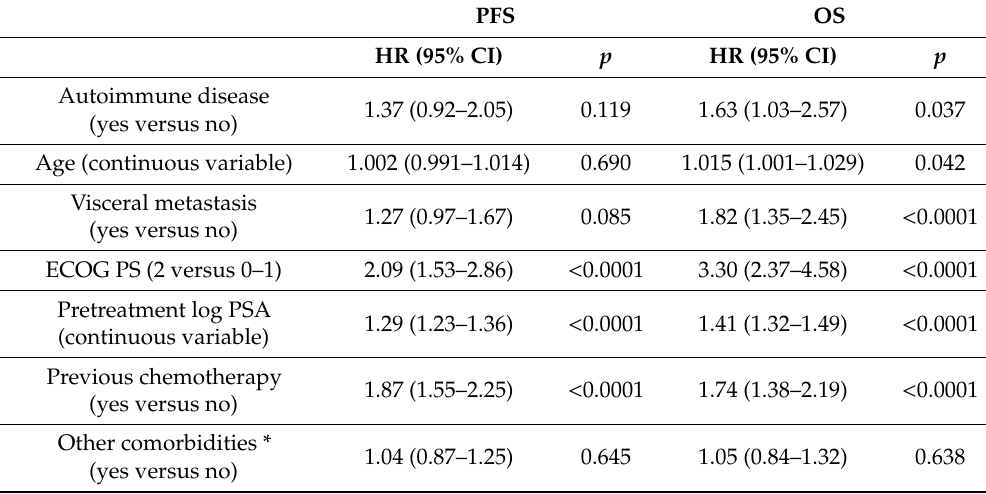
Table 3. Multivariable analysis of predictors of PFS and